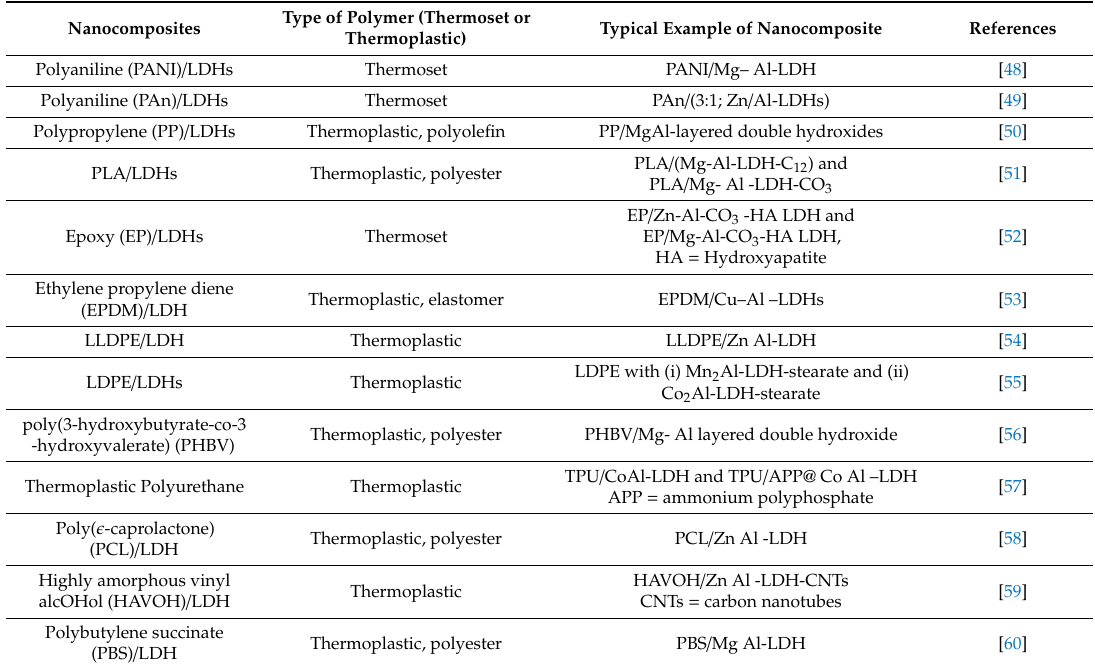
Table 1. LDHs nanocomposites with selective polymer